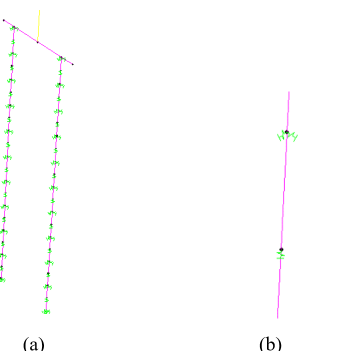
Figure 4. Soil-structure interaction: (a) 3D view of a block on two piles; (b) Horizontal and vertical springs applied at the nodes.